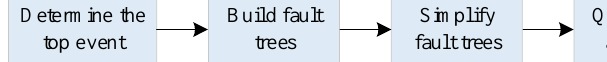
Figure 5. Typical power distribution system structure.